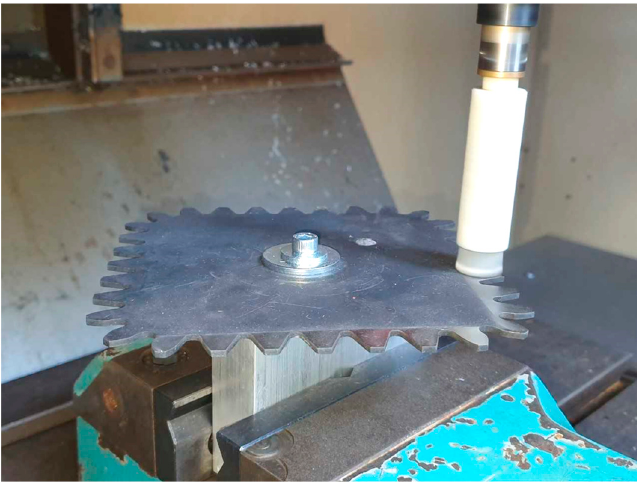
Figure 17. Deburring of a non-circular gear with rotary brushes with ceramic fibers.